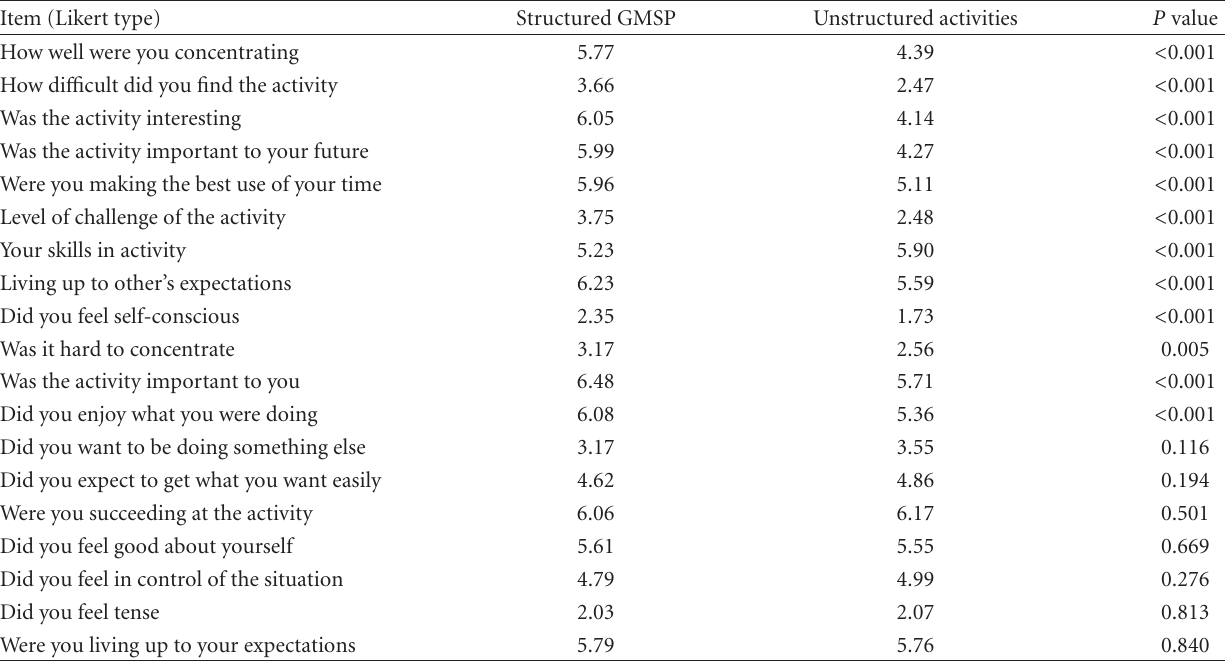
Table 2: E ff ect of GMSP on student perceptions of activity.